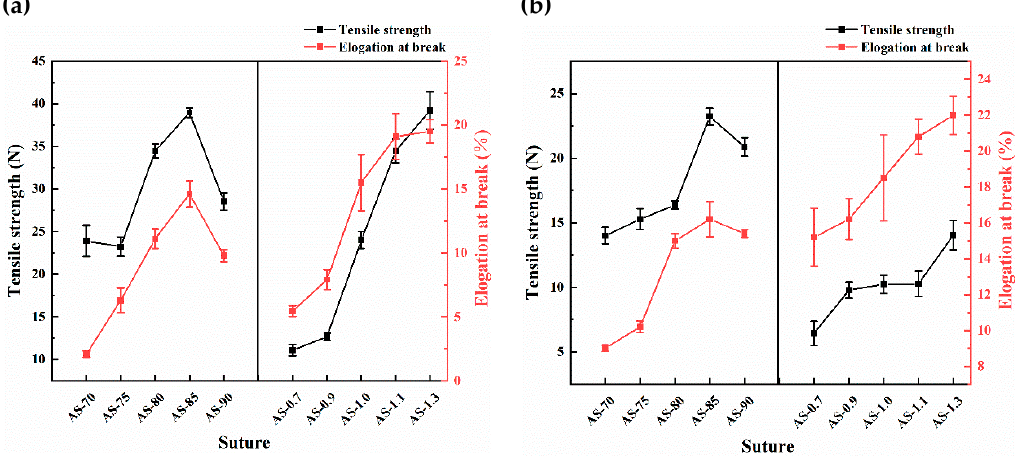
Figure 2. Mechanical properties of monofilaments ( a ) Dry and ( b ) Wet.